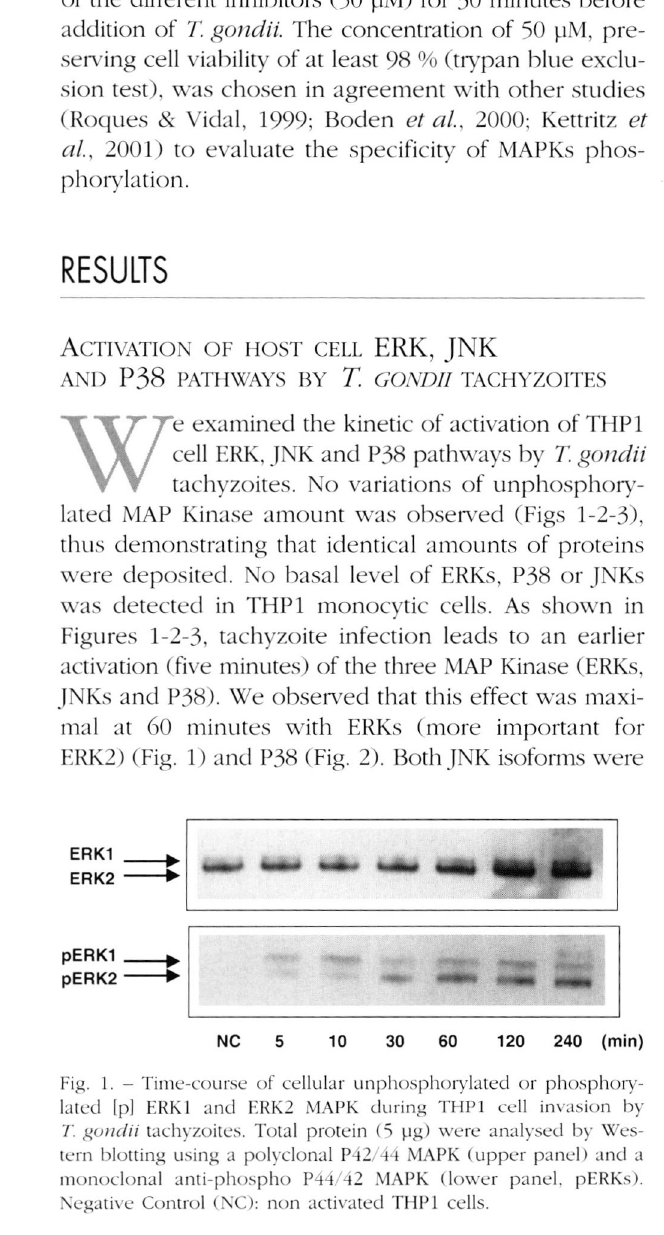
Fig. 3- - Time-course of cellular unphosphorylated or phosphory- lated [p] JNK1 and JNK2 MAPK during THP1 cell invasion by T. gondii tachyzoites. Total protein (10 µg) were analysed by Wes­ tern blotting using a polyclonal JNK1/JNK2 MAPK (upper panel) and a polyclonal anti-phospho JNK1/JNK2 MAPK (lower panel. pJNKs). Negative Control (NO: non activated THP1 cells.